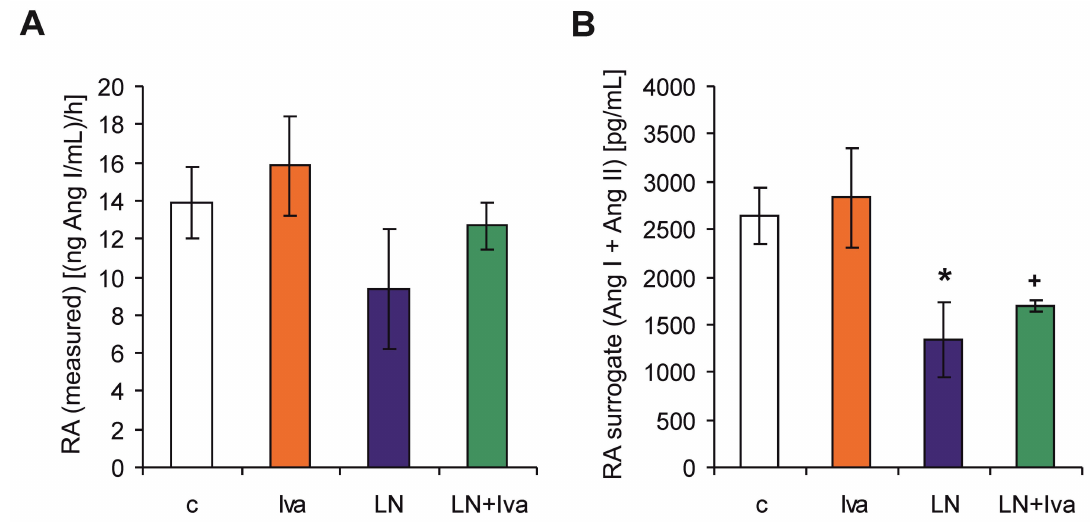
Figure 4. The influence of ivabradine (LN + Iva) on the measured renin activity (RA) ( A ) and surrogate renin activity (RA surrogate) ( B ) in the serum of L -NAME-treated rats. Wistar controls (c); L -NAME (LN); ivabradine (Iva); n = 6 per group; * p < 0.05 vs. c; + p < 0.05 vs. Iva; results are expressed as mean ±